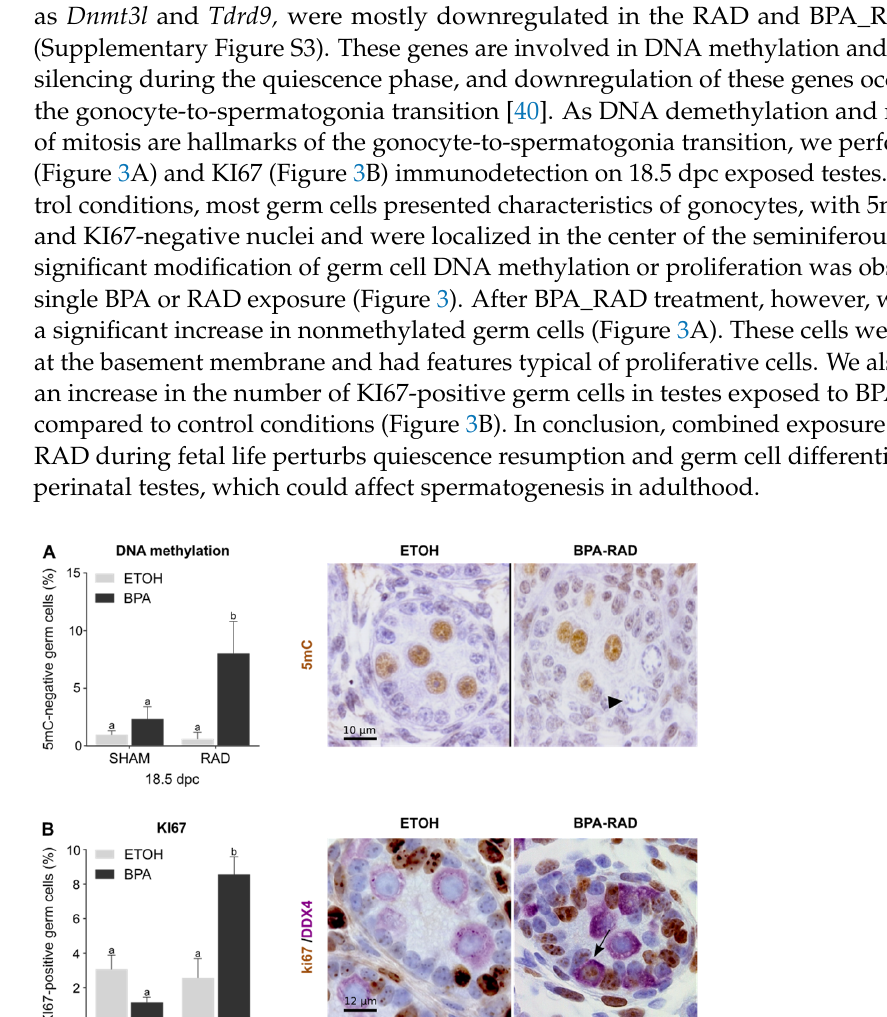
Protein coding mRNA